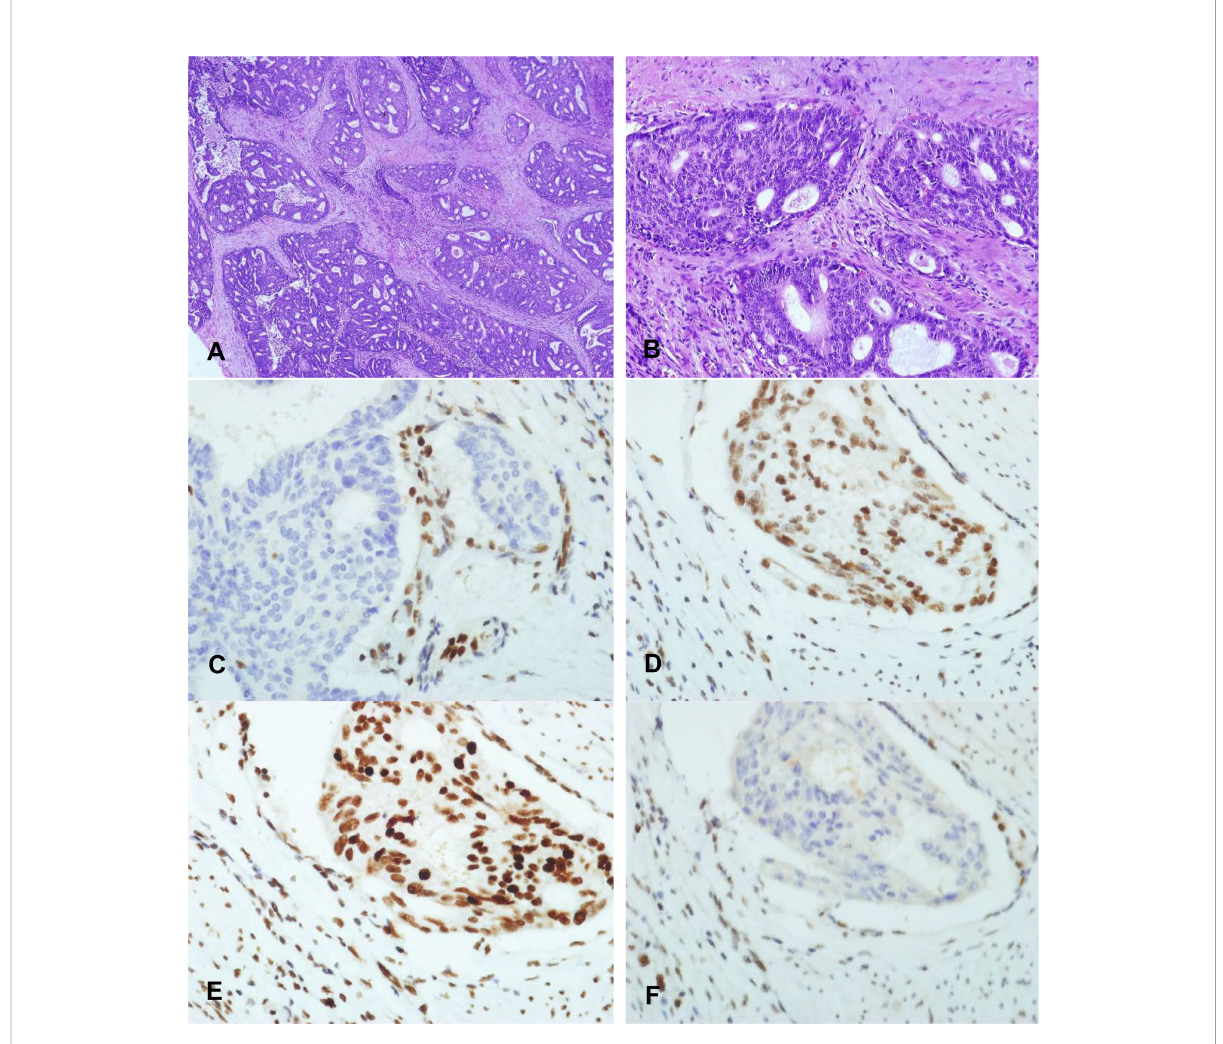
FIGURE 2 Immunohistochemical staining characteristics of EECs of MLH1 methylation. (A) X40 and (B) X100: Morphology of high-grade endometrioid adenocarcinoma with MLH1 methylation. (B) MLH1 protein expression pattern is completely absent of high-grade endometrioid adenocarcinoma with MLH1 methylation (X200). (C – F) MSH2, MSH6, and PMS2 protein are positive expression pattern of high-grade endometrioid adenocarcinoma with MLH1 methylation